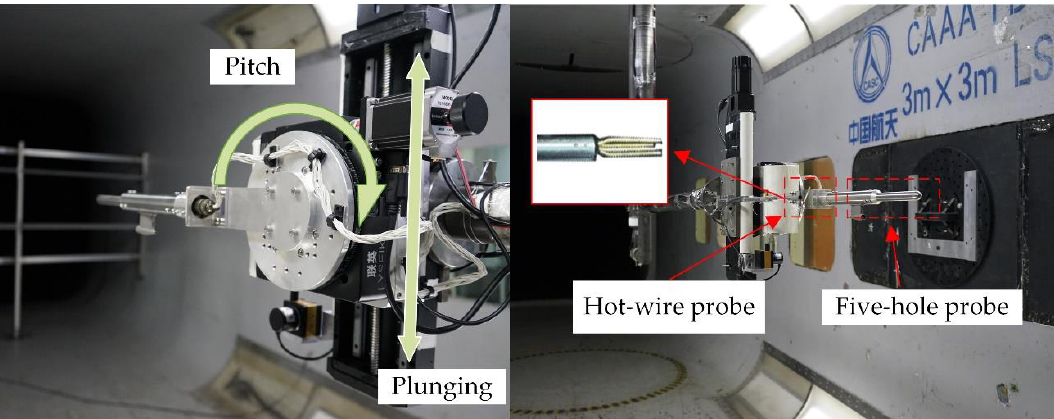
Figure 7. Plunging – pitching motion device for gust calculation test. Figure 7. Plunging–pitching motion device for gust calculation